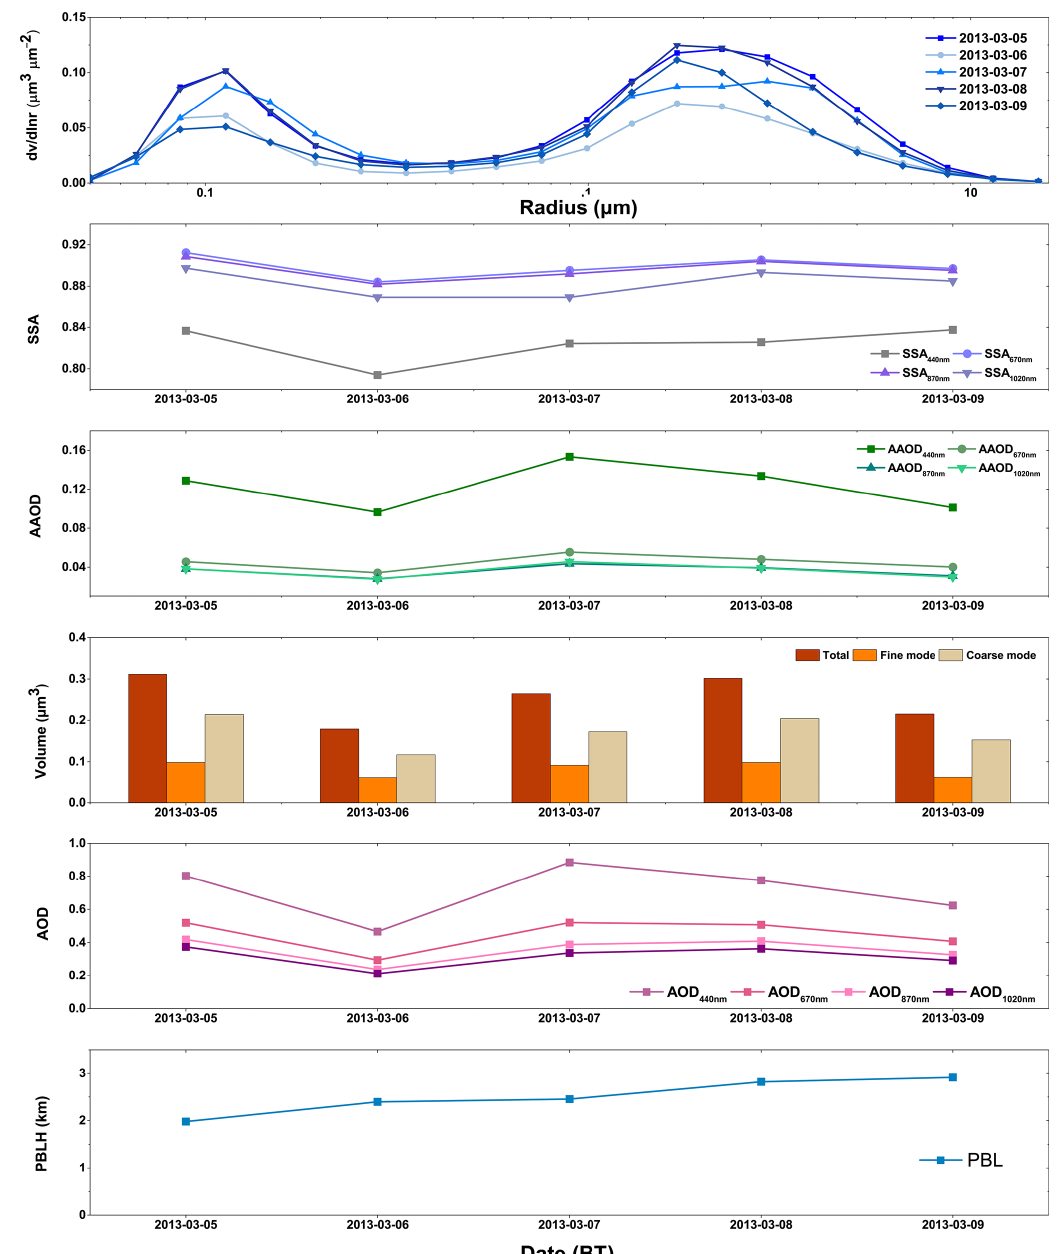
Figure 10. Daily averaged variation in aerosol optical properties and the PBLH in Hangzhou during 5–9 March